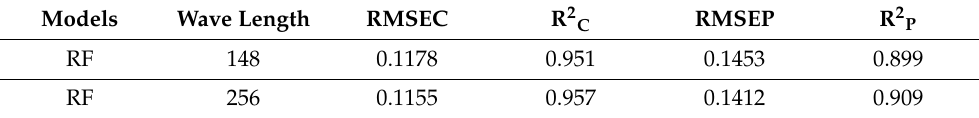
Table 7. Comparison of preferred wavelength and full-wavelength-based RF modeling results.